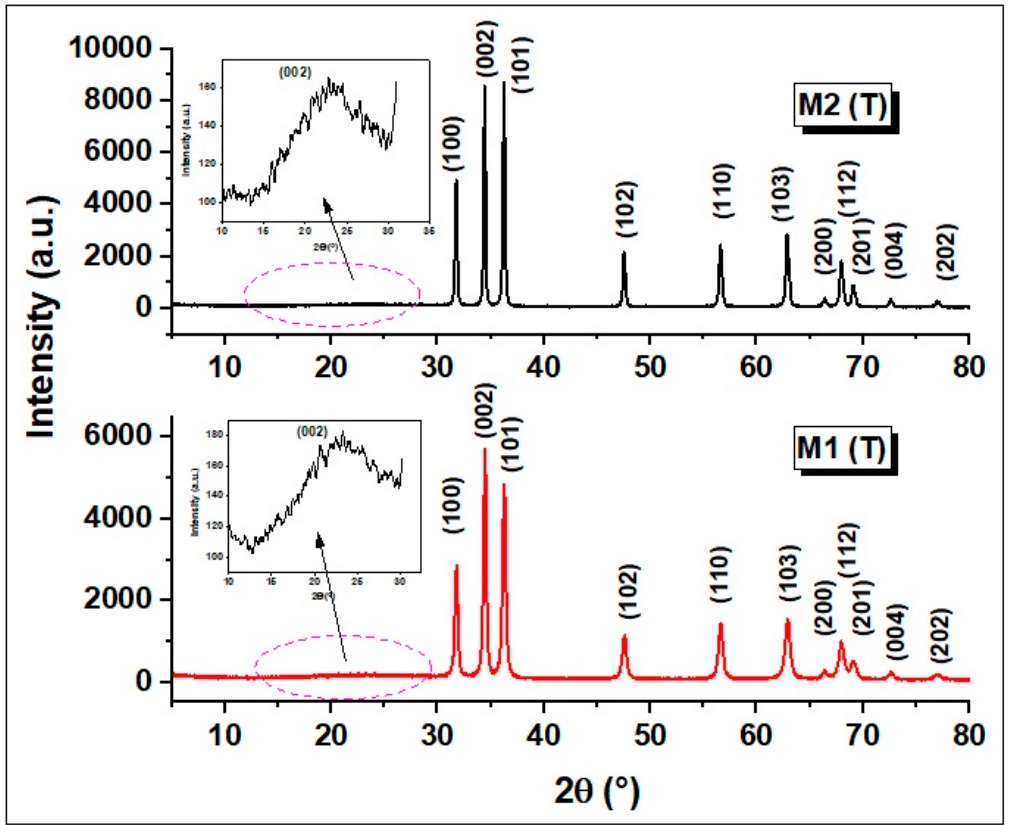
ff raction (XRD) patterns of M1 (T) and M2 (T) Figure 1. X-ray diffraction (XRD) patterns of M1 (T) and M2 (T) samples. Figure 1. X-ray di